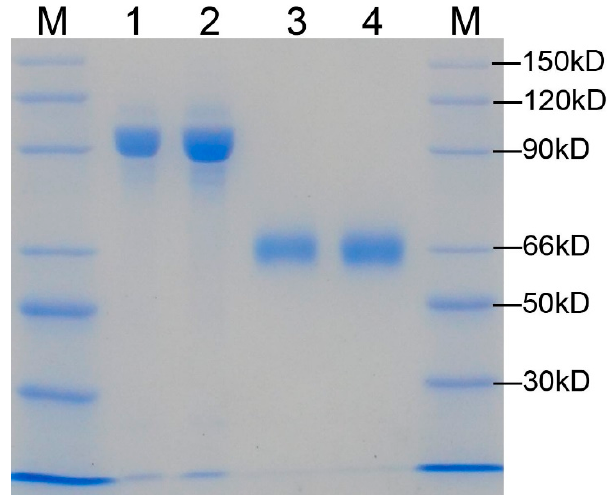
Figure 2. Gel image of SDS-PAGE for the purified AHAS. Lane 1: GST-AHAS-WT; Lane 2: GST- AHAS- Δ W548; Lane 3: mature AHAS-WT; Lane 4: mature AHAS- Δ W548. M: protein marker. The molecular weights of bands in the marker were indicated.